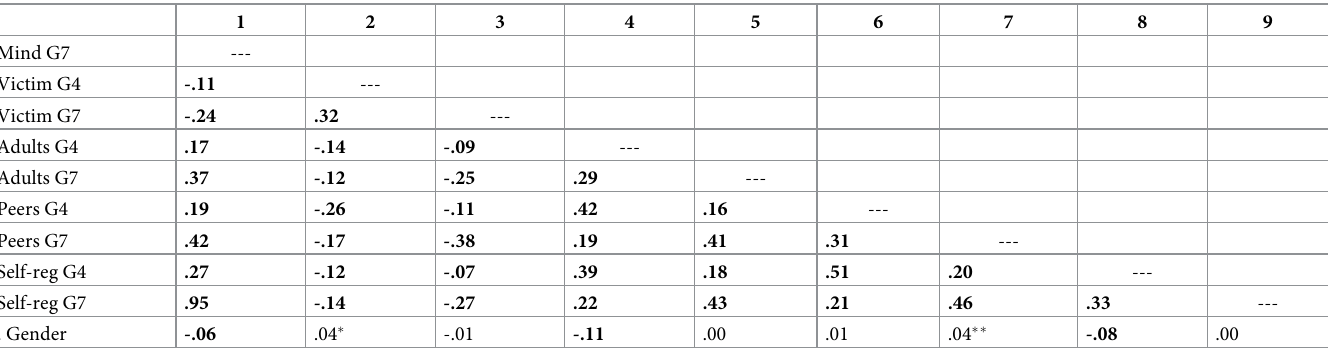
Table 1. Correlations among study variables ( N = 4,593).